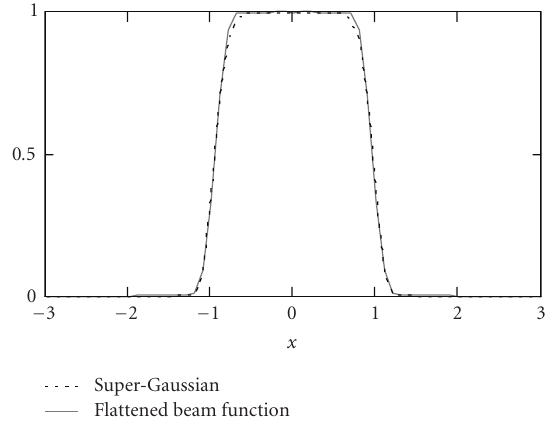
Figure 3.1. Comparison between a super-Gaussian with p = 10 (dotted curve) and a flattened beam function F ( bx , m ), b = 4 . 76, m = 20 (solid curve); the two curves are undistinguishable.